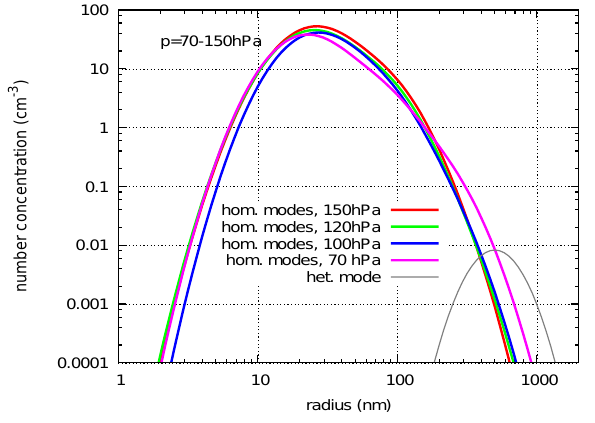
Fig. 6. Initial size distributions of sulfuric acid droplets in the TTL for the pressure levels 70/100/120/150hPa (colour code indicated in the inset legend), as derived from a 2-D aerosol model (Weisenstein et al., 2007); additionally, the size distribution of the heterogeneous ice nuclei as used for heterogeneous nucleation is indicated (grey